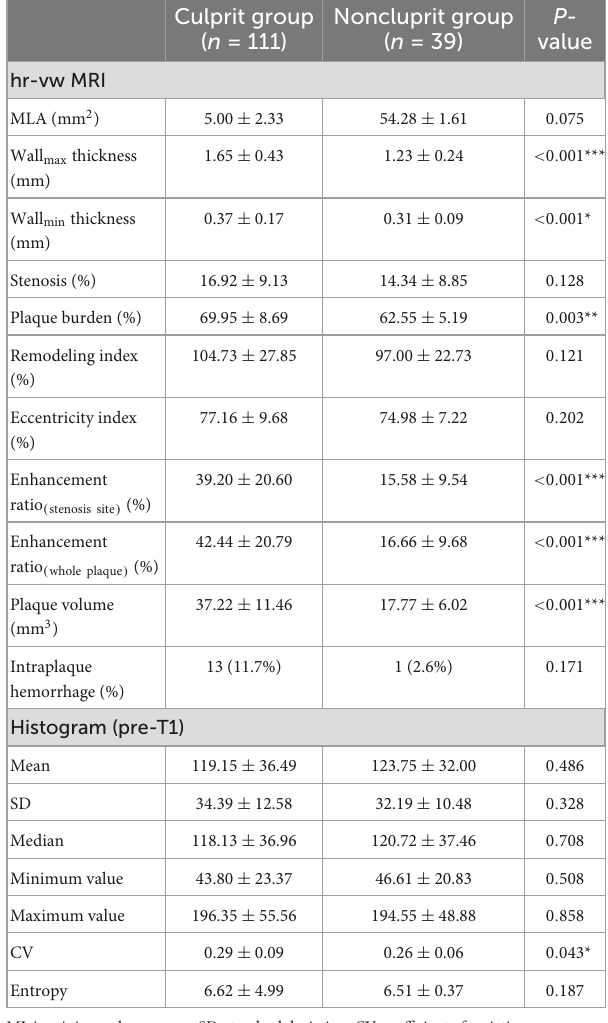
TABLE 2 Comparison of high-resolution vessel wall magnetic resonance imaging (hr-vw MRI) characteristics and histogram features between culprit and non-culprit